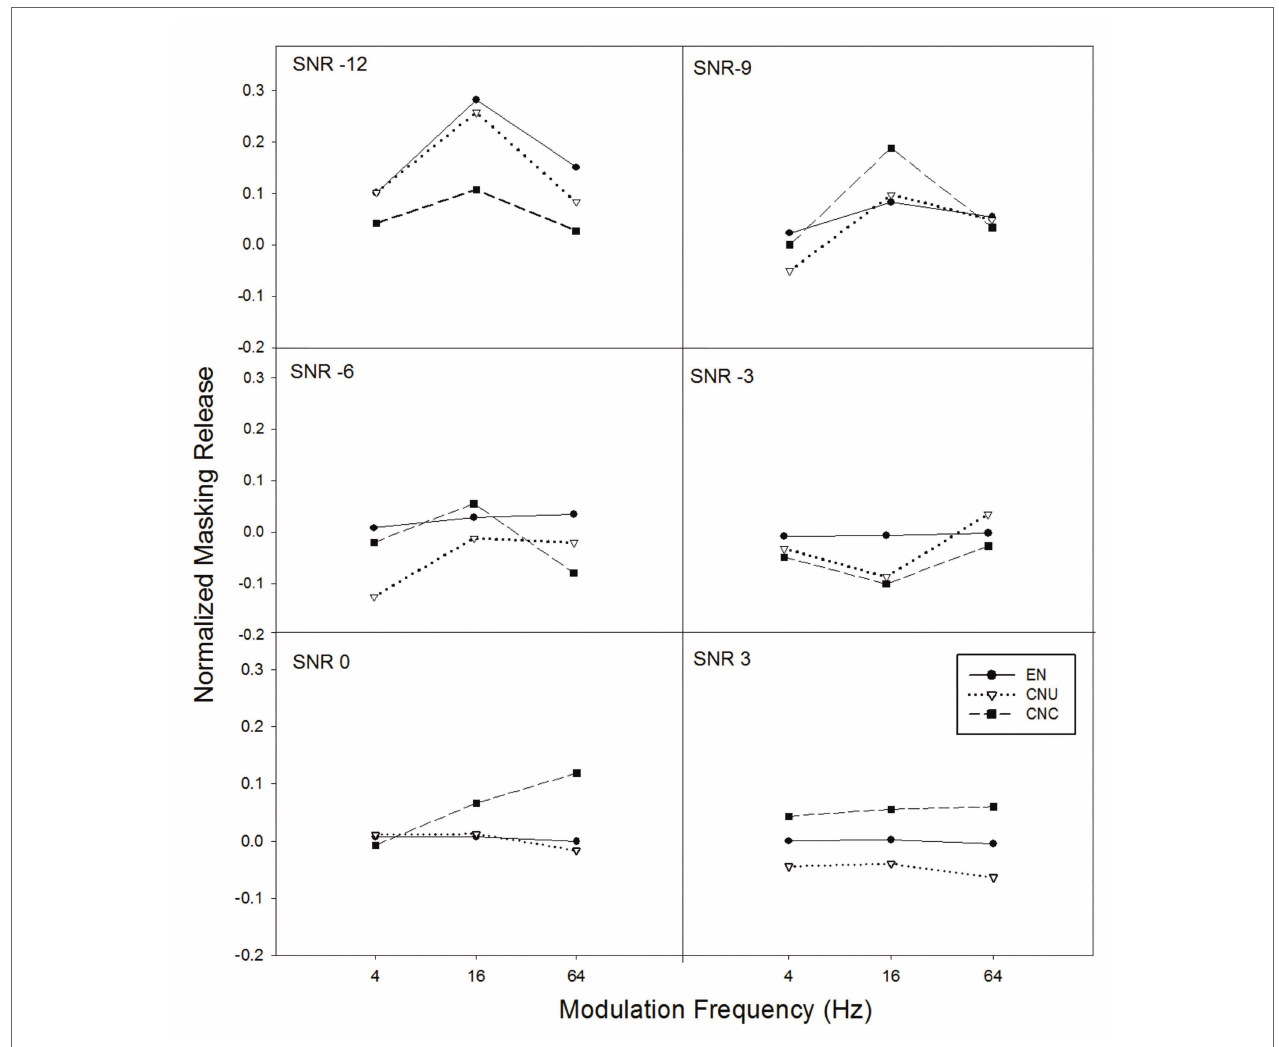
FIGURE 4 | The normalized masking release from the temporal modulation of noise (e.g., normalized scores in temporally-modulated noise minus normalized scores in stationary noise) as a function of temporal modulation frequency of noise for six SNRs (−12, −9, −6, −3, 0, and 3 dB for each panel) for three groups of listeners: EN listeners, CNU, and